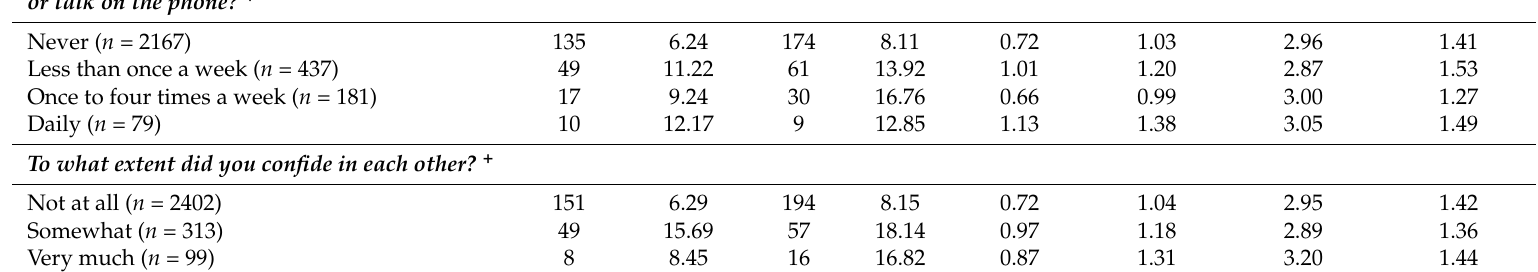
Table 3. Degree of friendship and serious suicidal ideation/behavior, depression, and attitudes about coping and help-seeking strategies in exposed schools. Friendship Items